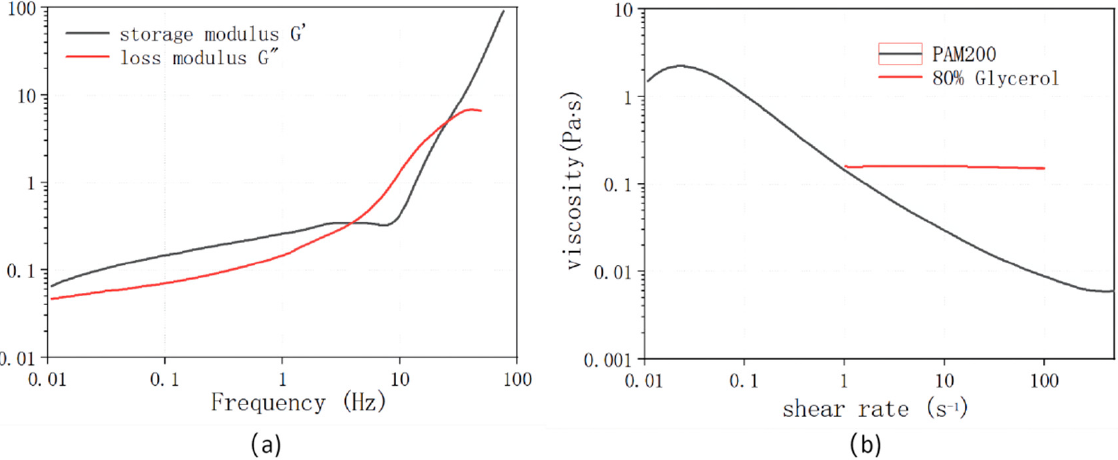
Figure 2. ( a ) Complex shear modulus of the PAM solution and ( b ) the viscosity of the PAM solution and the glycerol solution. and the glycerol